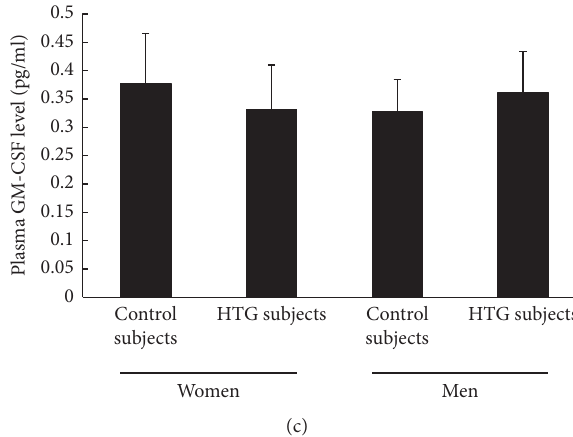
Figure 3: The plasma levels of NO, VEGF, and GM-CSF. (a) The plasma levels of NO in normotriglyceridemic and hypertriglyceridemic men were statically lower than those in the female groups ( P < 0 . 05). In the male groups, the level of NO was decreased in hyper- triglyceridemic subjects than that in normotriglyceridemic subjects ( P < 0 . 05). The plasma levels of NO between normotriglyceridemic and hypertriglyceridemic premenopausal female groups displayed no significant difference ( P > 0 . 05). (b) and (c) The plasma level of VEGF and GM-CSF had no statistical difference between the four